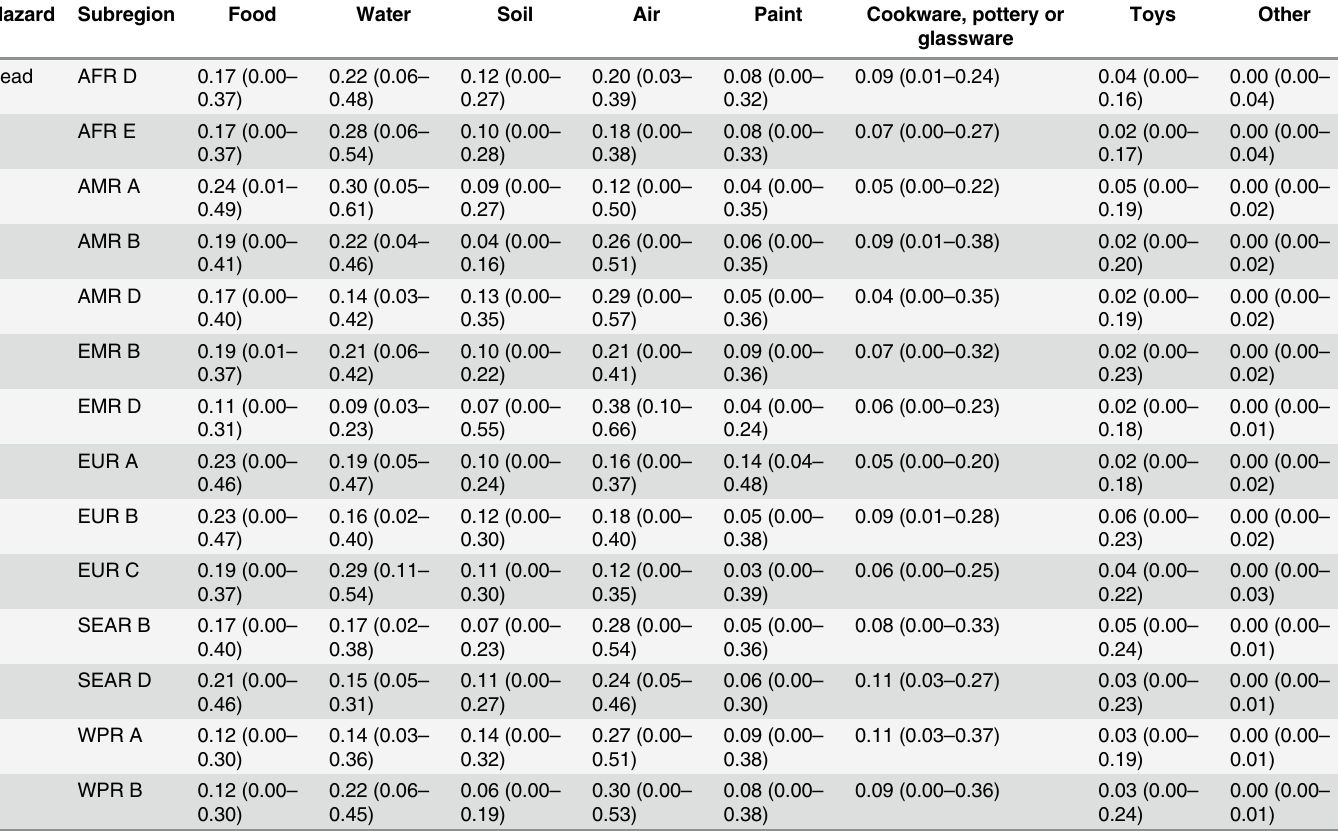
Table 9. Subregional estimates (median and 95% uncertainty interval) of the proportion of illnesses caused by exposure to lead through each pathway. Hazard Subregion Food Water Soil Air Paint Cookware, pottery or